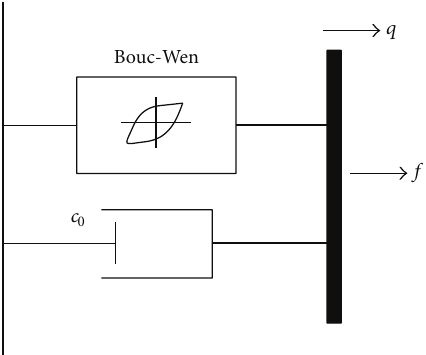
Figure 12: Simple mechanical model of MR.